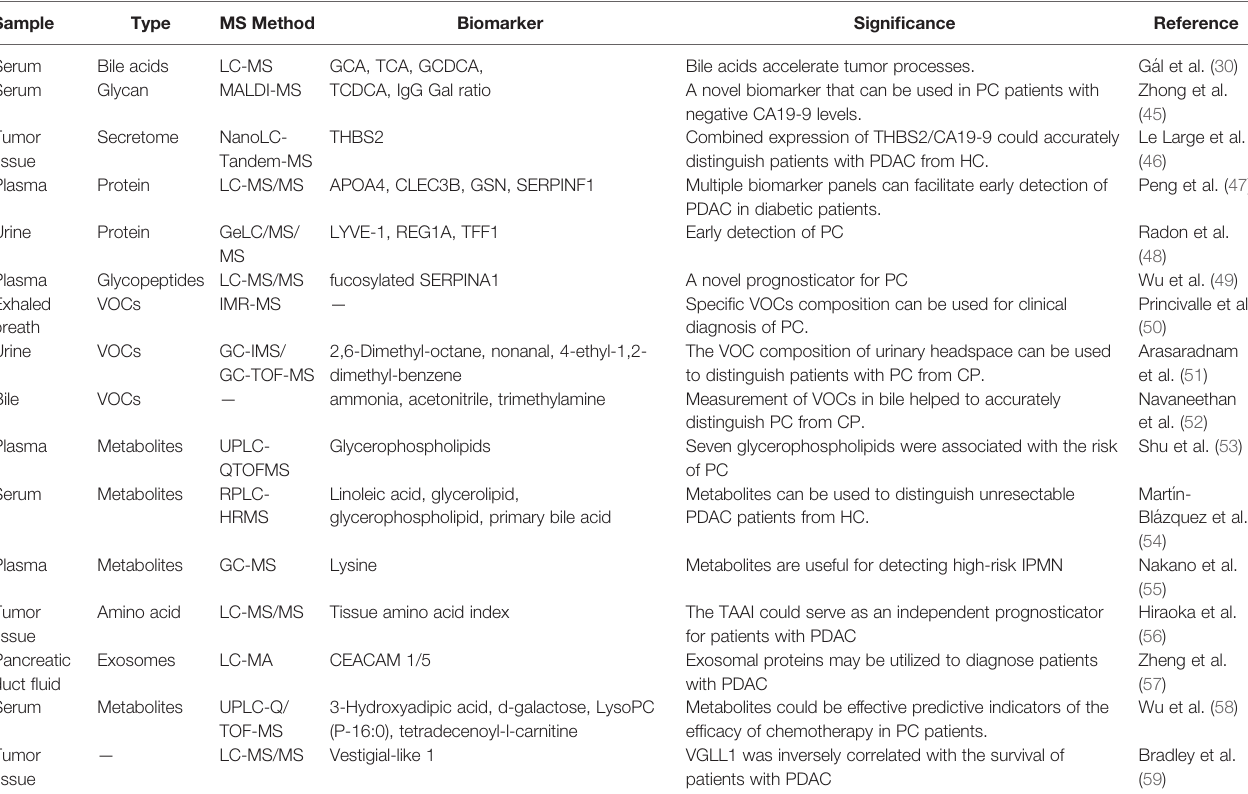
TABLE 2 | Novel biomarkers of pancreatic cancer using